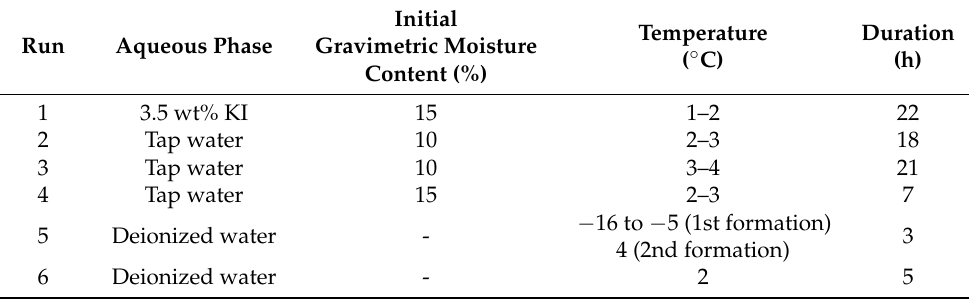
Table 1. Experimental conditions in the synchrotron XRCT runs (1–4) and the optical microscopy runs (5–6). All experiments were conducted at 7 MPa. Initial Temperature Duration Run Aqueous Phase Gravimetric Moisture ( ◦ C) (h) Content (%) 1 3.5 wt% KI 15 1–2 22 2 Tap water 10 2–3 18 3 Tap water 10 3–4 21 4 Tap water 15 2–3 7 − 16 to − 5 (1st formation) 3 5 Deionized water - 4 (2nd formation) 6 Deionized water - 2